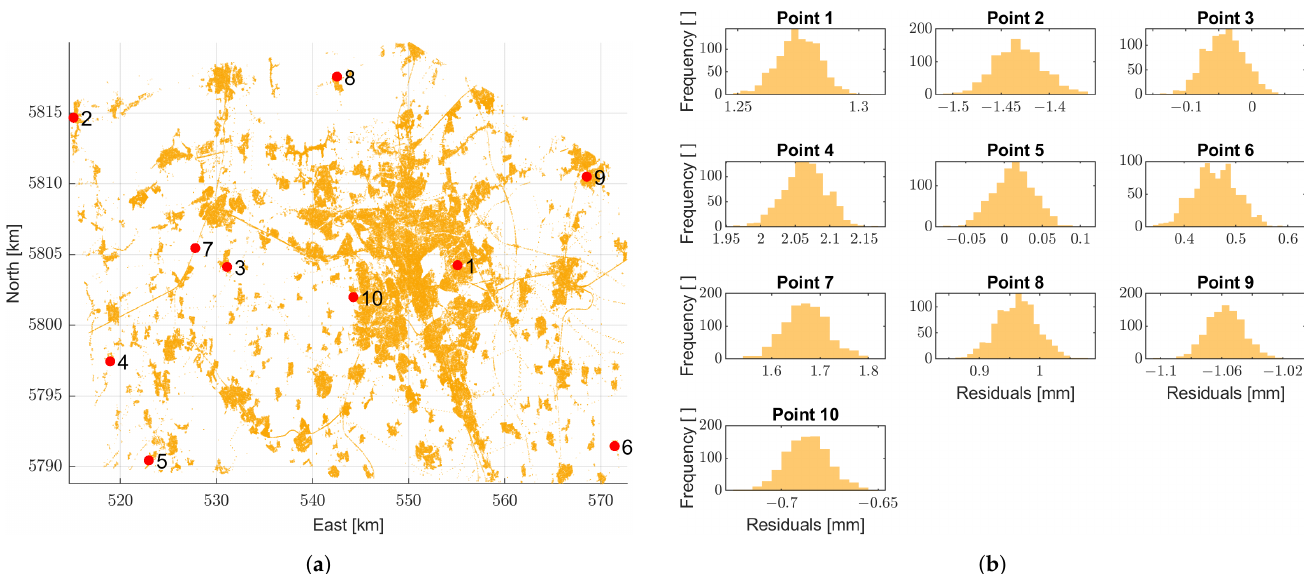
Figure 10. Histogram of predicted value based on all bootstrap samples in 10 arbitrary points. ( a ) Observations and 10 chosen points (red). ( b ) Histograms.